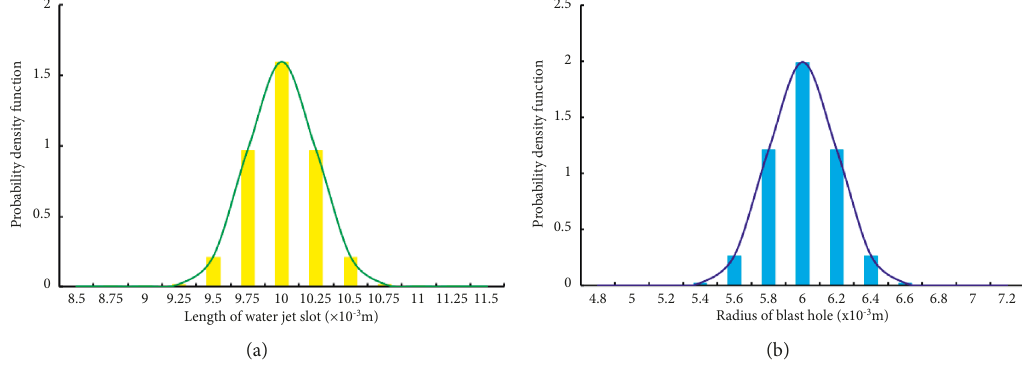
Figure 29: Probability density function of l s and r b . (a) Length of water jet slot. (b) Radius of blast hole. Table 3: Parameters of normal distributions for geometrical dimensions of blast hole. Distributional model